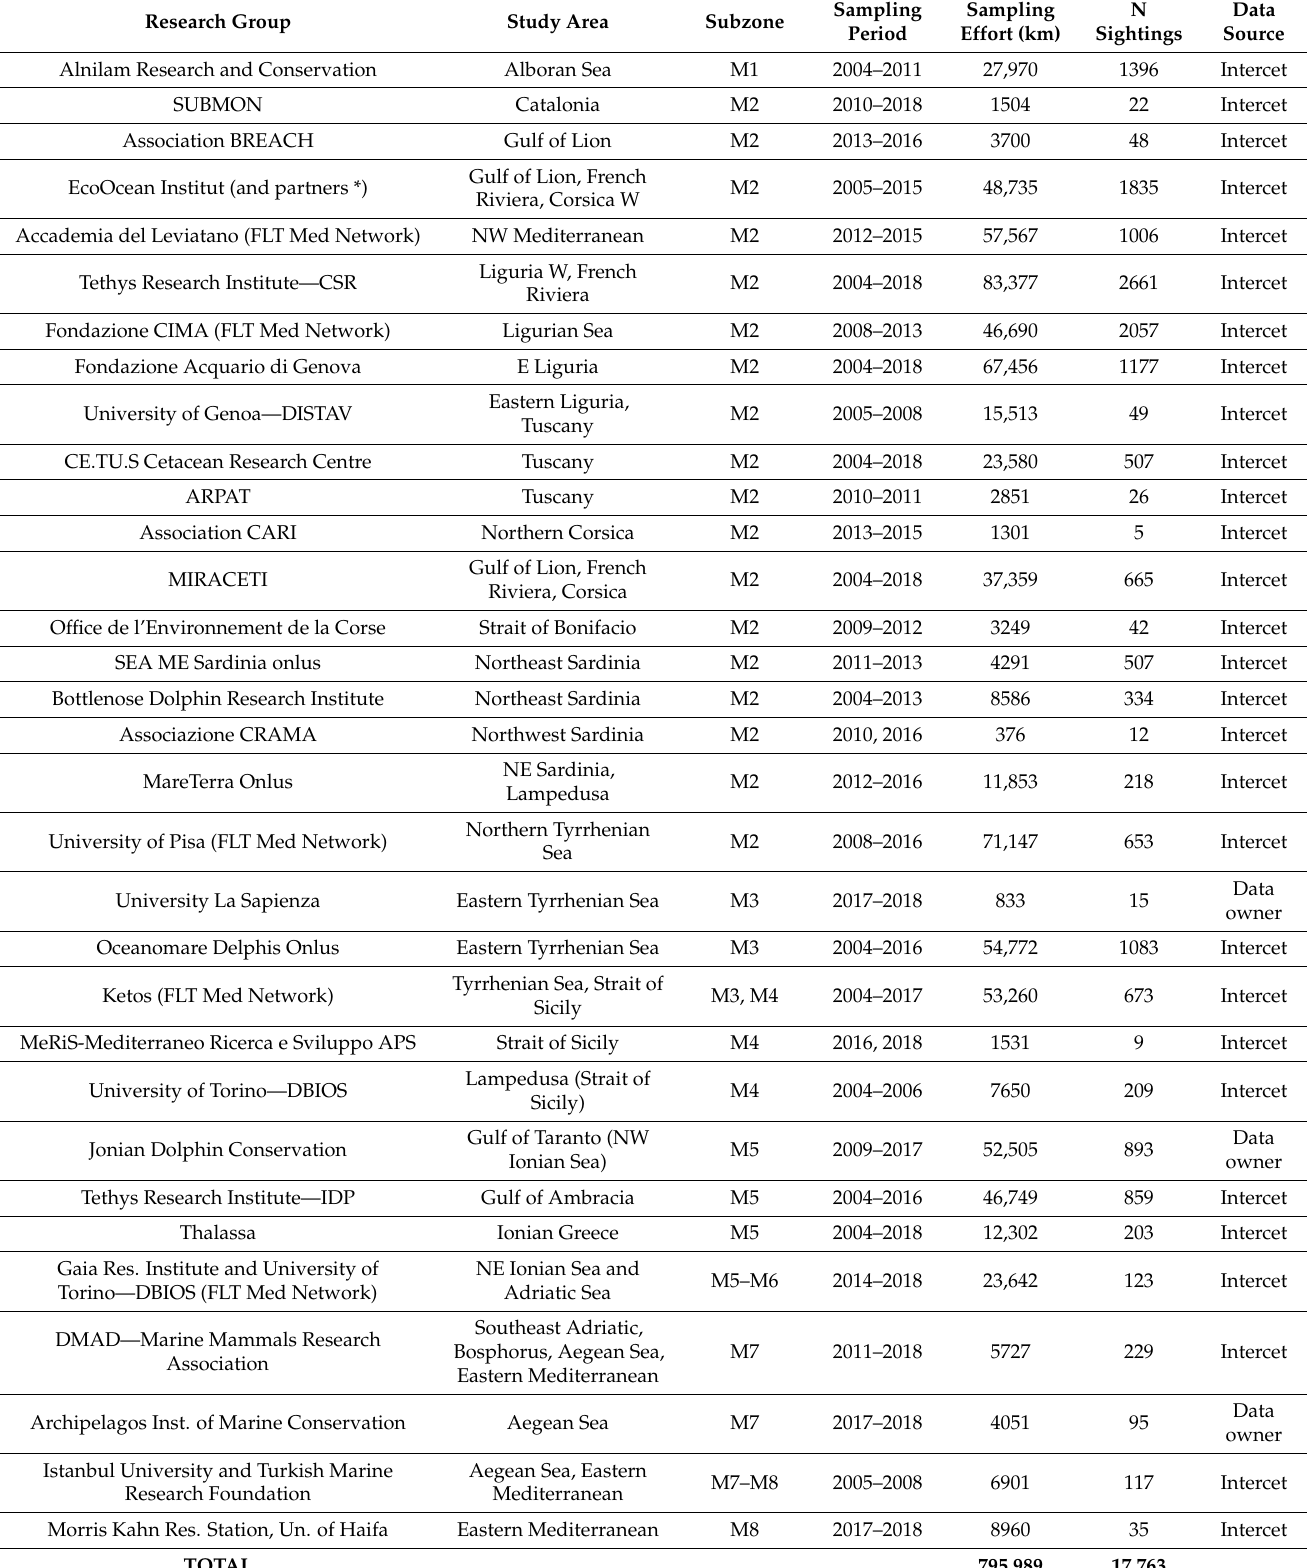
Table 1. Research groups, study area, and sampling period for the common dataset analysed.